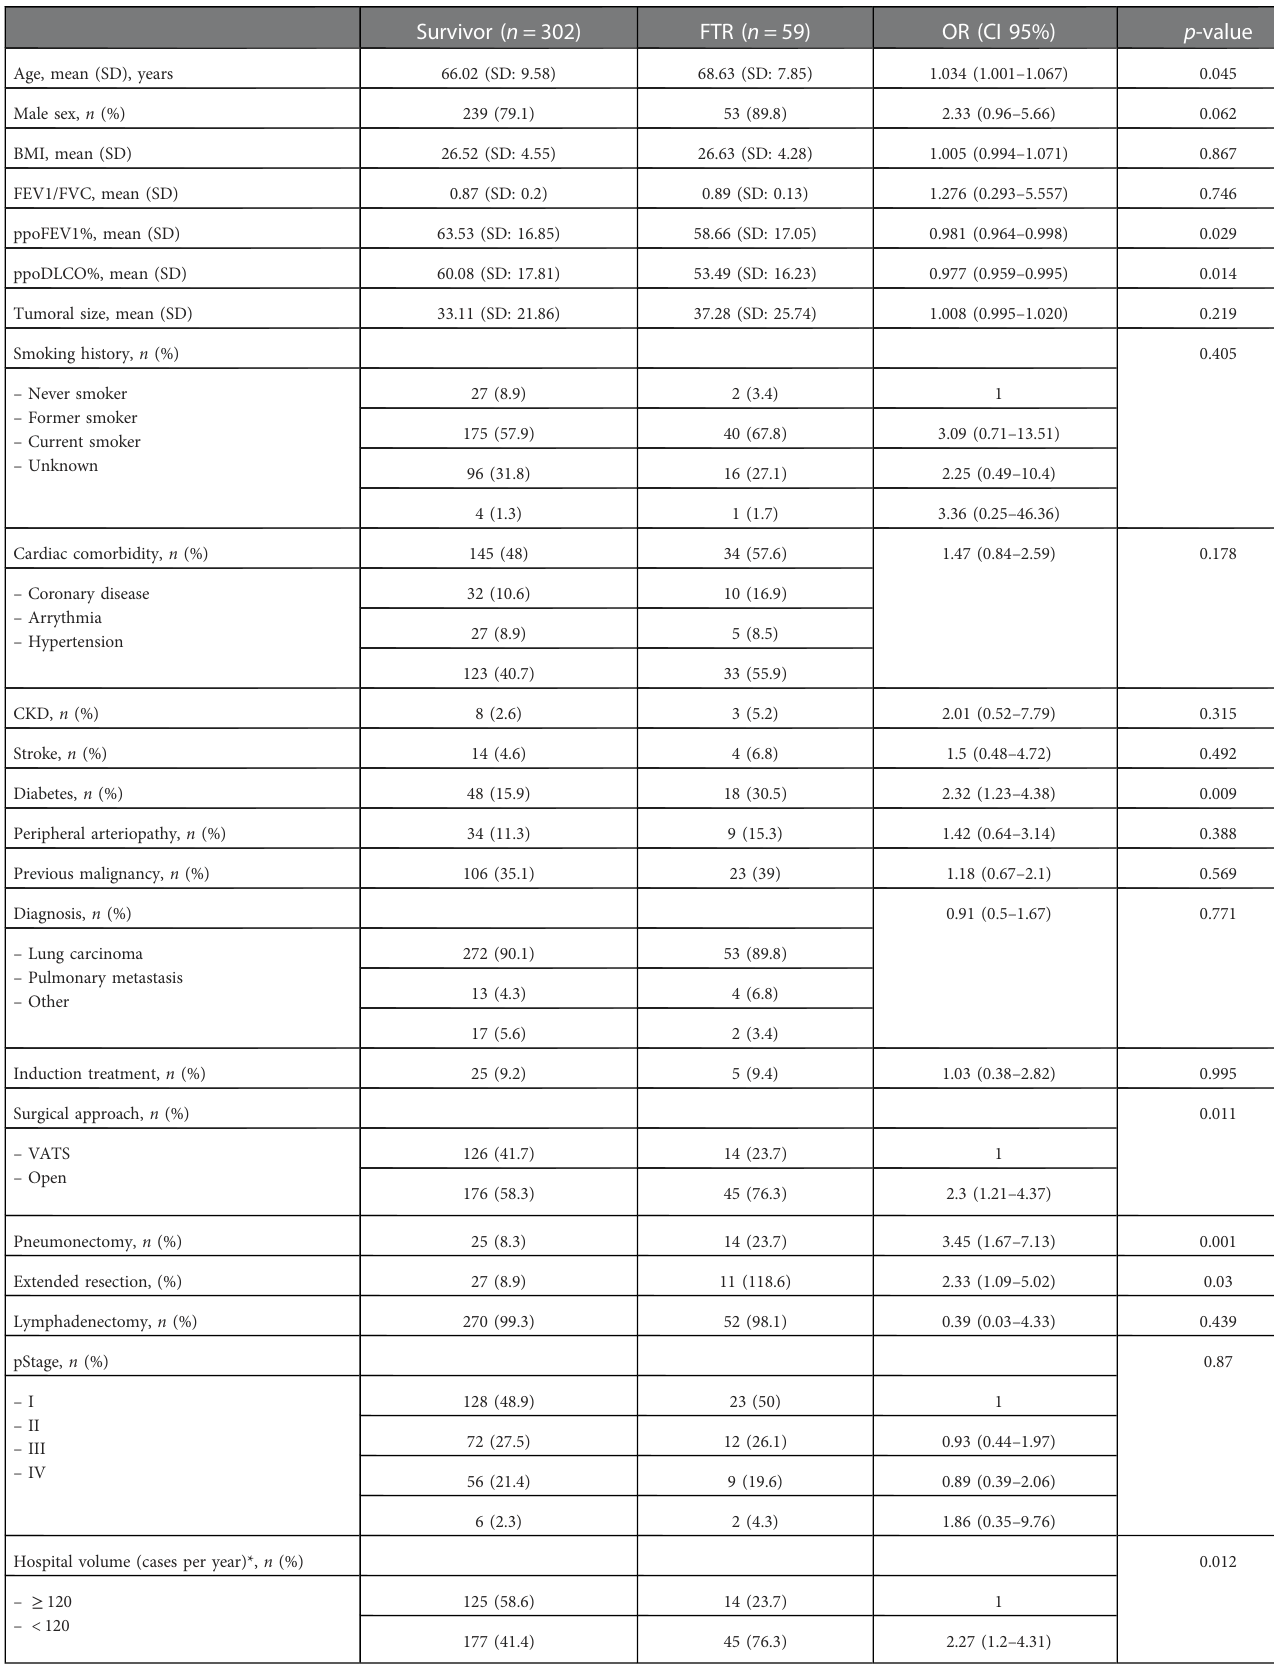
TABLE 1 Univariate analysis of patient characteristics, surgical features, and hospital volume for the dependent variable of FTR following pulmonary anatomical lung